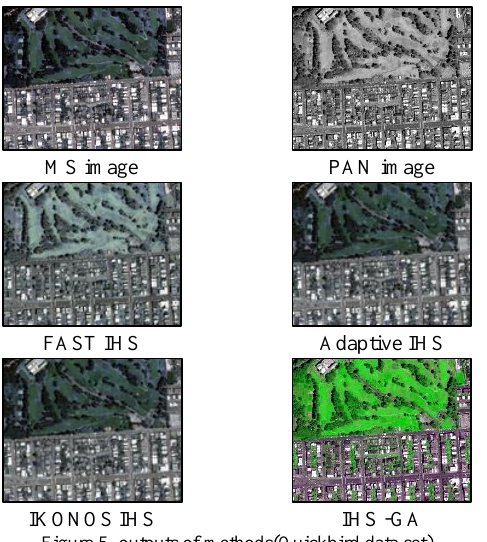
Figure 5. outputs of methods(Quickbird data